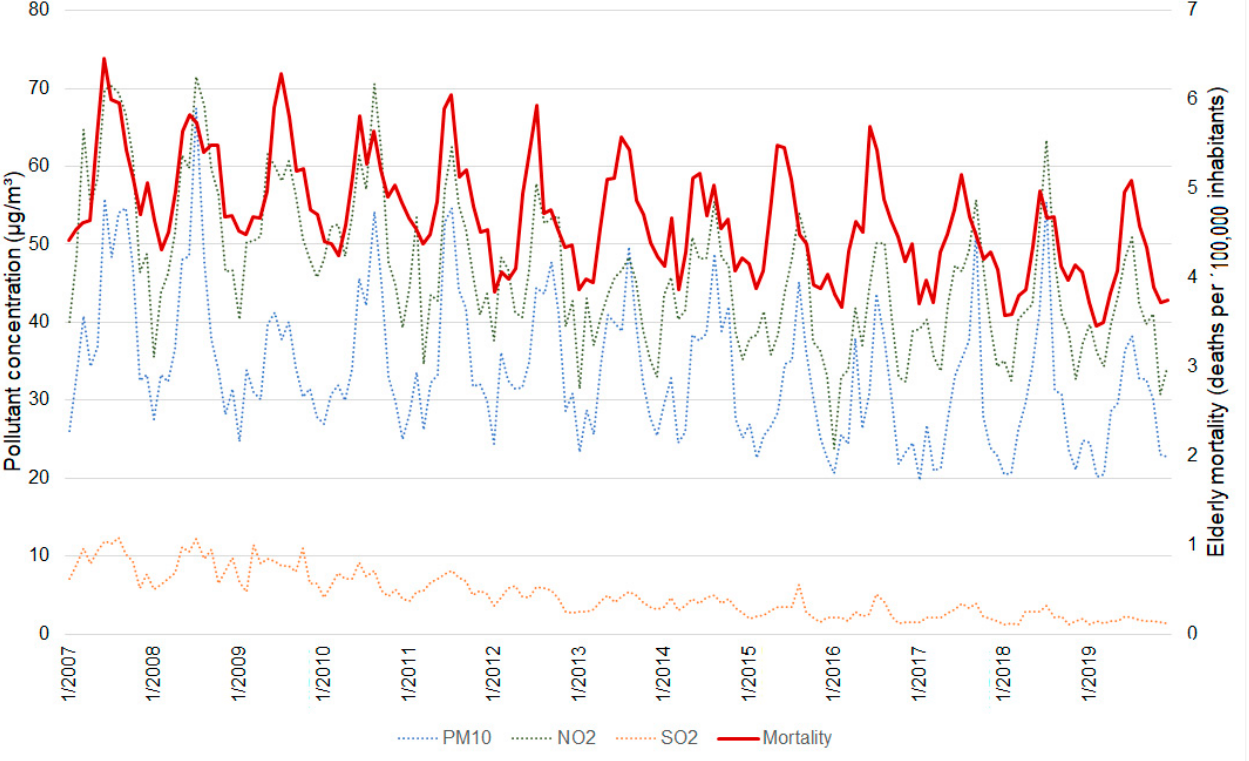
Figure 3. Line graph showing the daily variation of the concentrations of PM 10 , NO 2 , and SO 2 variables and elderly mortality between 2007 and 2019.